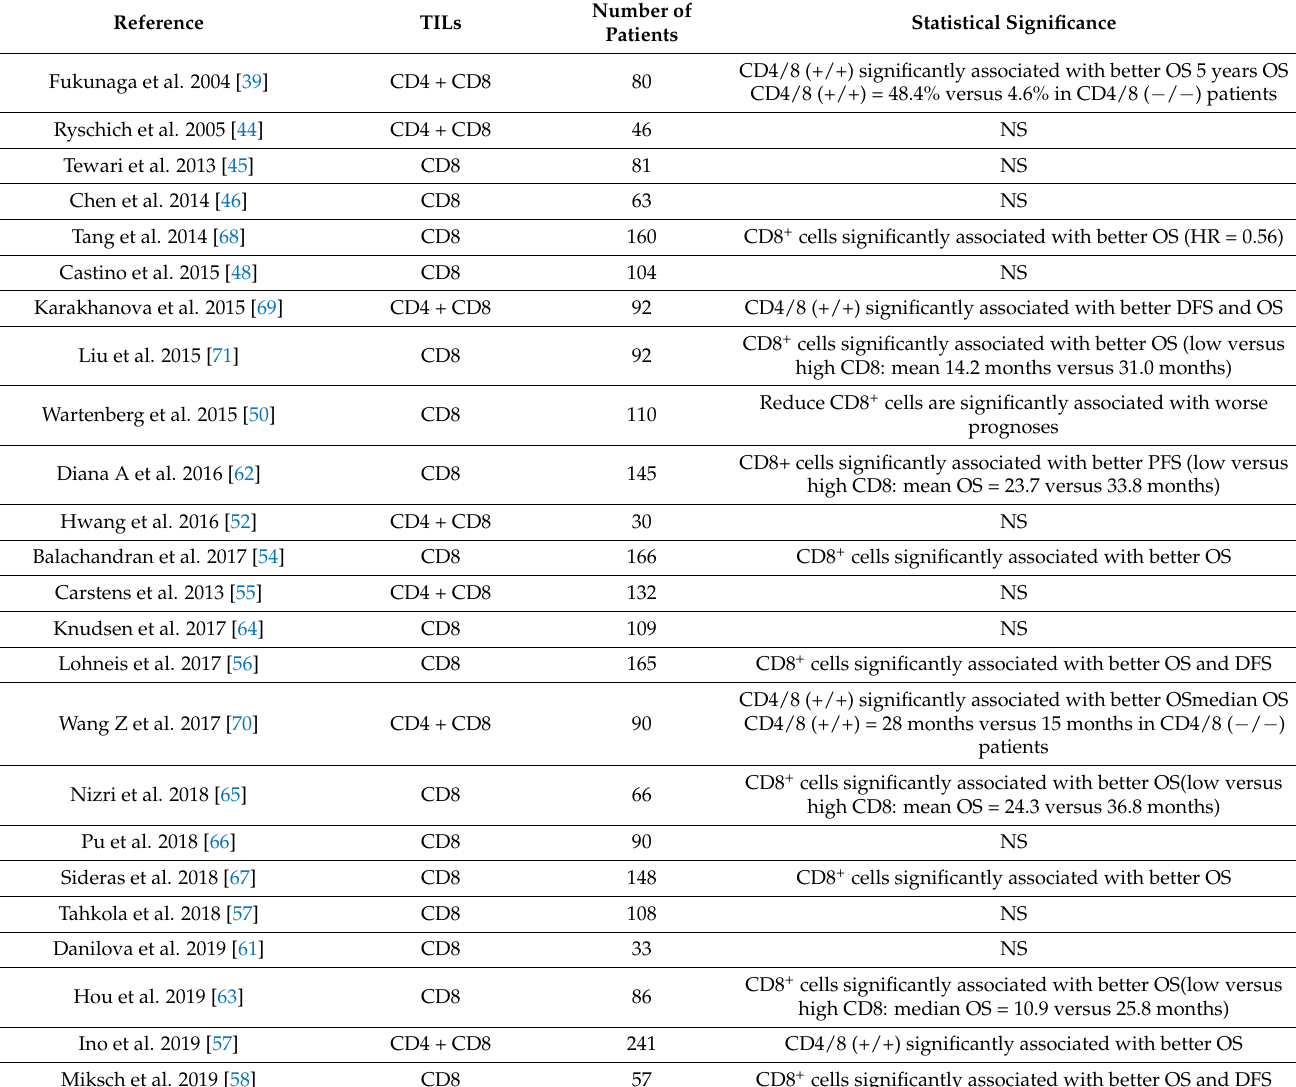
Table 2. Studies assessing CD4 and CD8 T-cell expression in pancreatic ductal adenocarcinoma and the correlation with survival